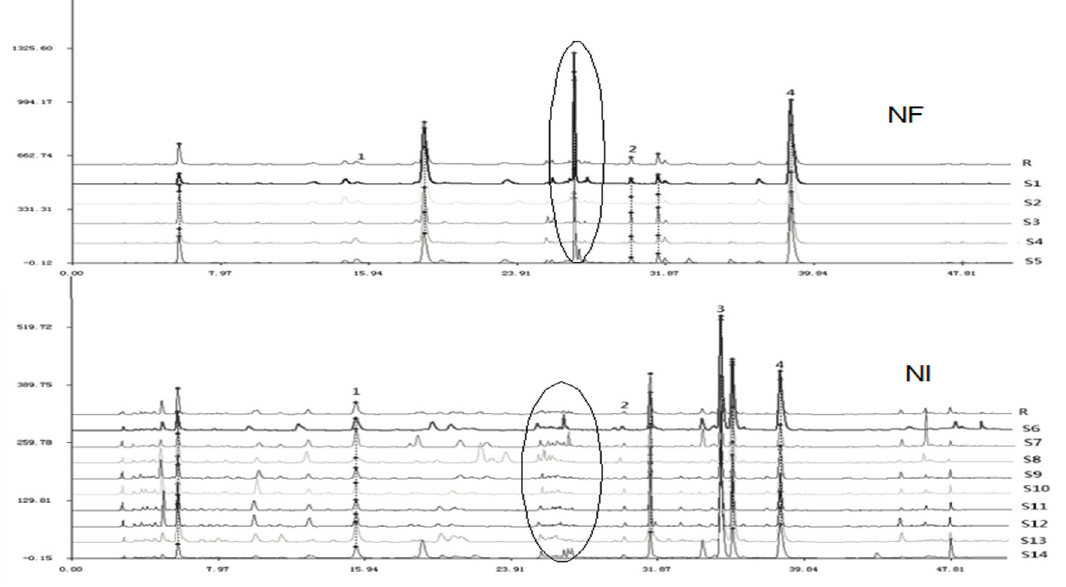
Figure 4. HPLC fingerprints of 14 batches of Qianghuo samples (R, reference